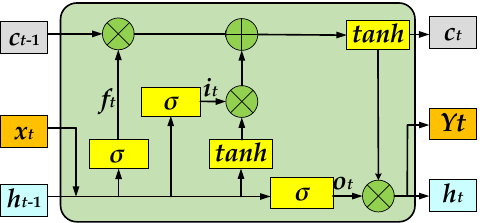
Figure 4. The LSTM model in the trajectory prediction of the ICVs.